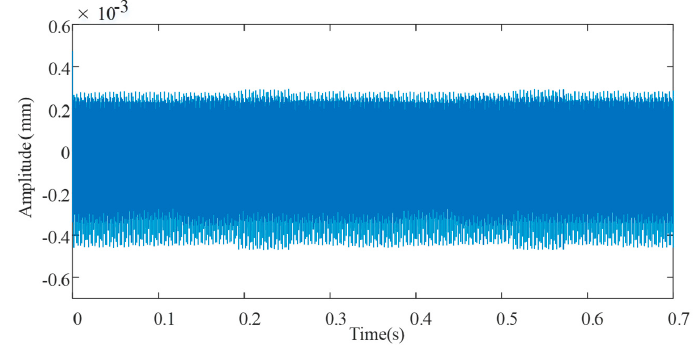
Figure 13. Simulation signal in healthy condition.